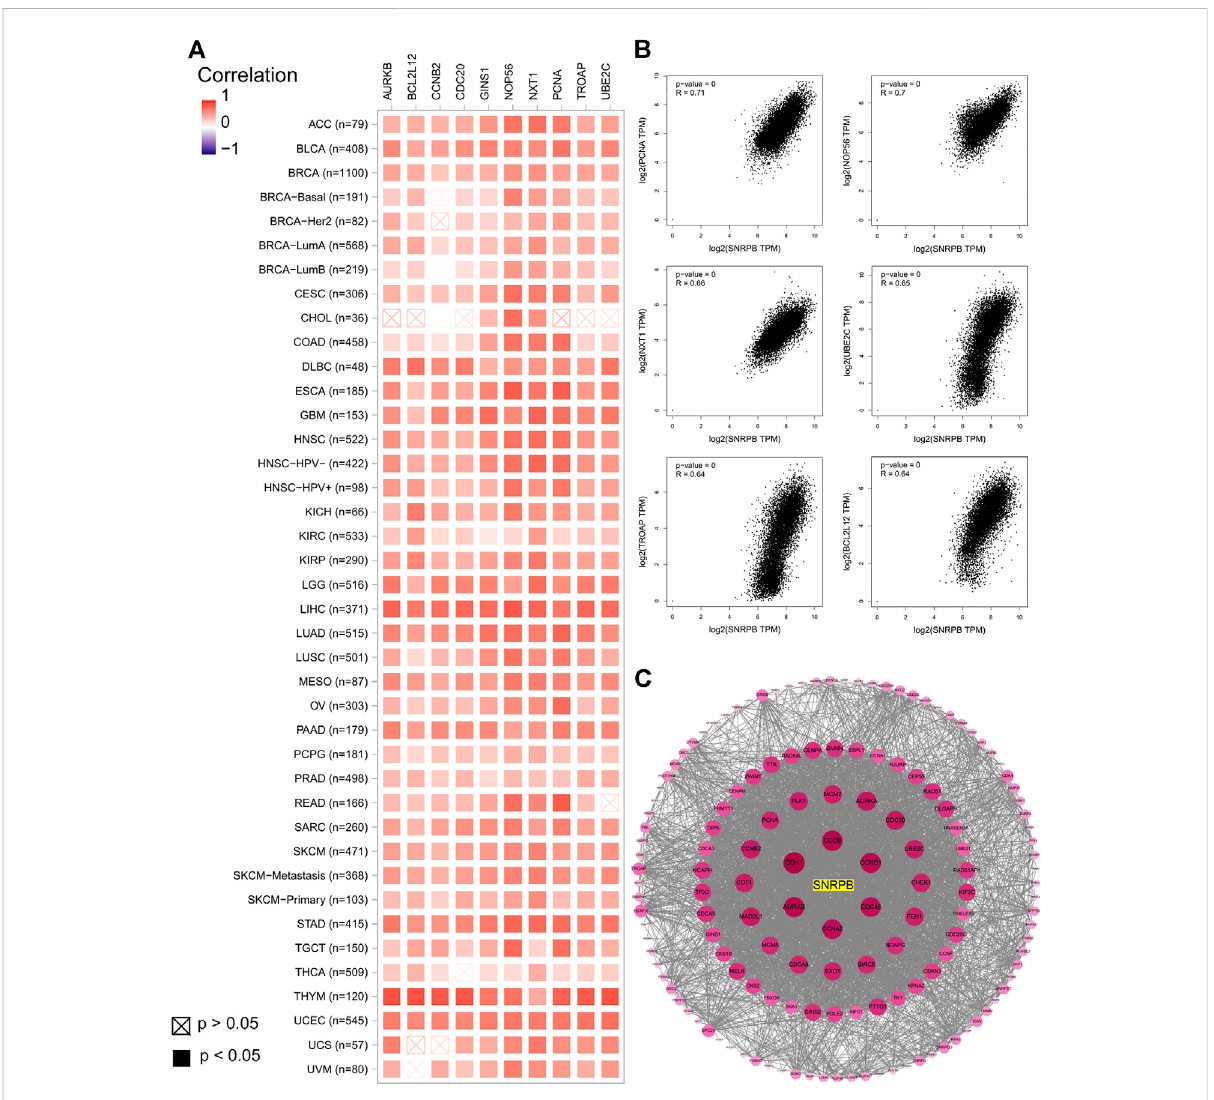
FIGURE 9 Coexpressed genes of SNRPB across tumors. (A) . Top 10 coexpressed genes of SNRPB across tumors. (B) . Representative fi gures of the relationshipbetweenSNRPB and the top 6 coexpressed genes across tumors. (C) . PPI network ofSNRPB and the top 100 coexpressed genes across